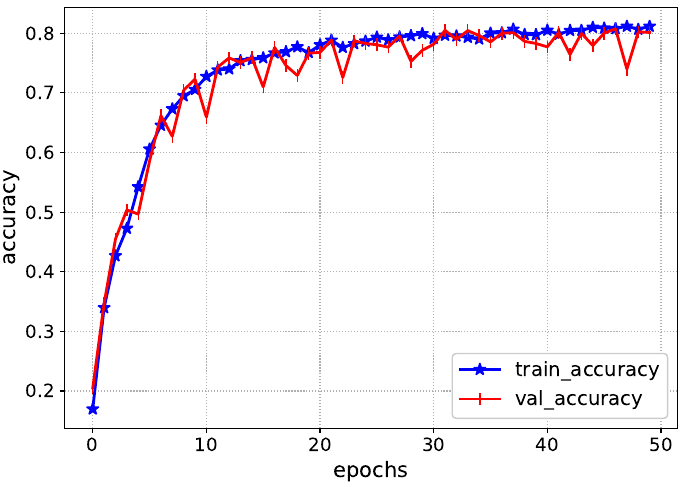
Figure 6. Accuracy of Inception-V4 during training.